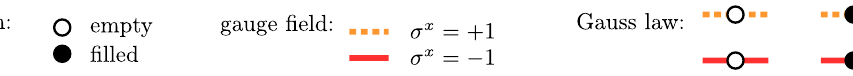
Figure 1: The Hilbert space of the (cid:90) gauge theory, which can be made from fermionic 2 sites and spin-1 / 2 links. The only allowed combinations are those satisfying the Gauss